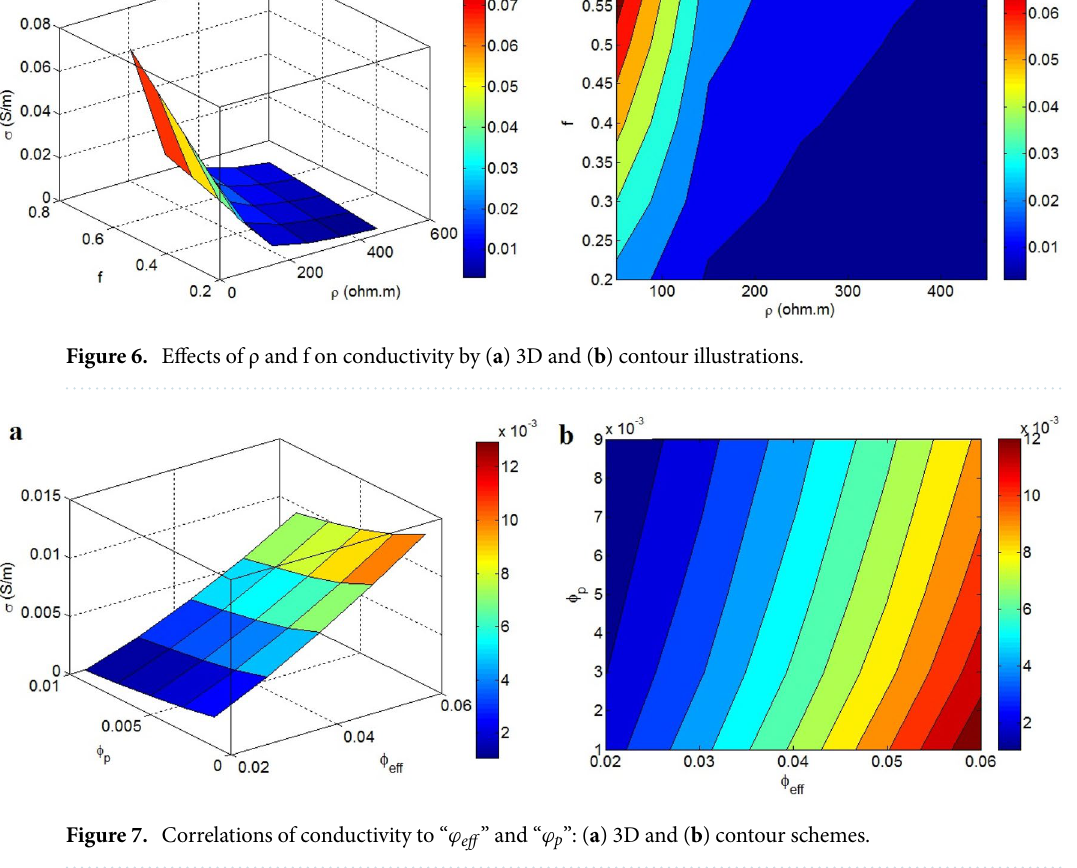
Figure 7. Correlations of conductivity to “ ϕ eff ” and “ ϕ p ”: ( a ) 3D and ( b ) contour